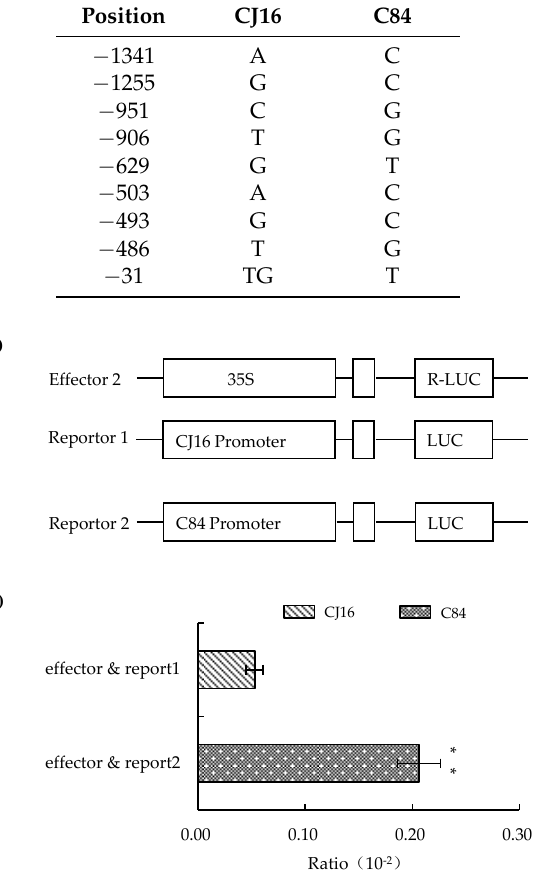
Table 6. The position of nine SNPs in the promoter of LOC_Os09g26999.